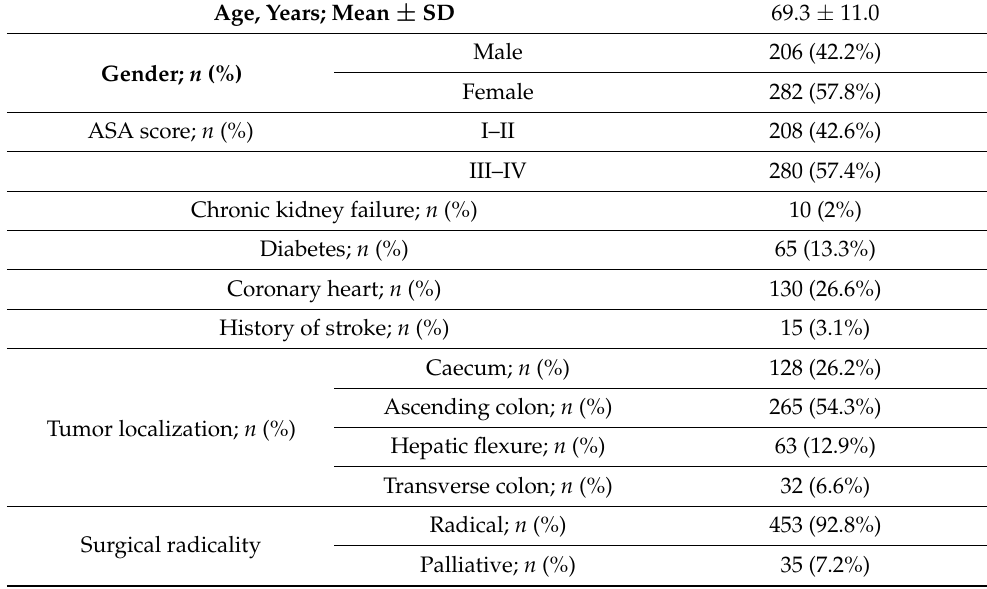
Table 1. Baseline characteristics of the study